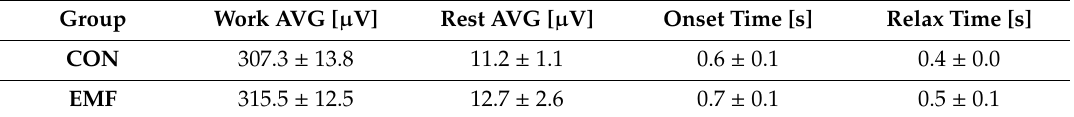
Table 4. The results of the selected EMG parameters for the control group (CON) and the group exposed to EMF (EMF; using handheld and portable devices of wireless communication). Parameters described in text. The data are expressed as mean values ± SEM.